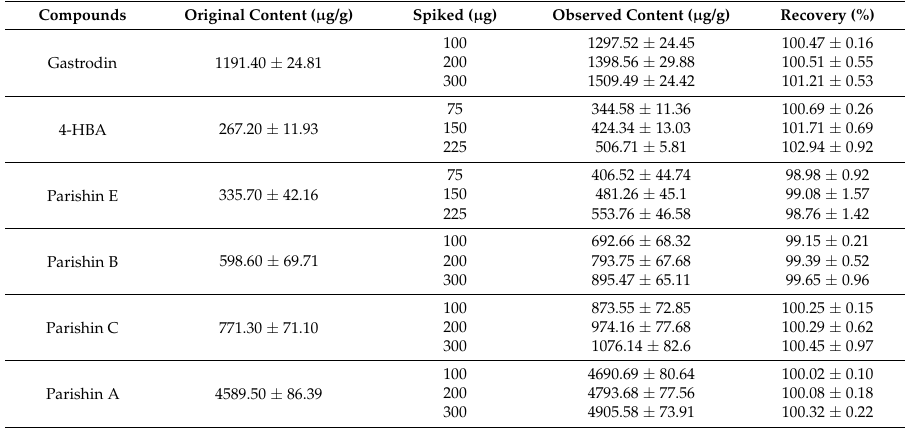
Table 4. Recovery tests of six parishin derivatives.